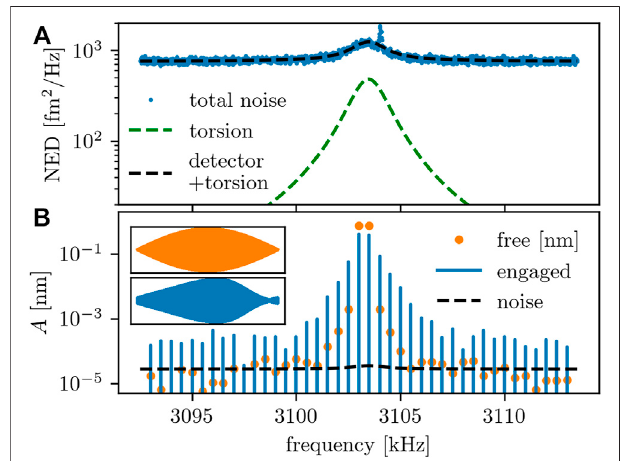
FIGURE 1 | Thermal noise and multifrequency lock-in spectra. (A) Measured noise-equivalent-de fl ection (NED) after 500 averages. The black curve is a fi t to a model which sums independent contributions: a frequency- dependenttorsionalnoiseofthecantileverandafrequency-independent noise of the detector. This fi t calibrates the cantilever and detector, as explained in the text. (B) Measured response at 41 intermodulation product frequencies. Orange dots are the freeresponse far away from the surface and blue bars are the engaged response. These spectra are a frequency-domain representation of the envelope modulating the rapid lateral oscillation of the tip. The time domain is shown in